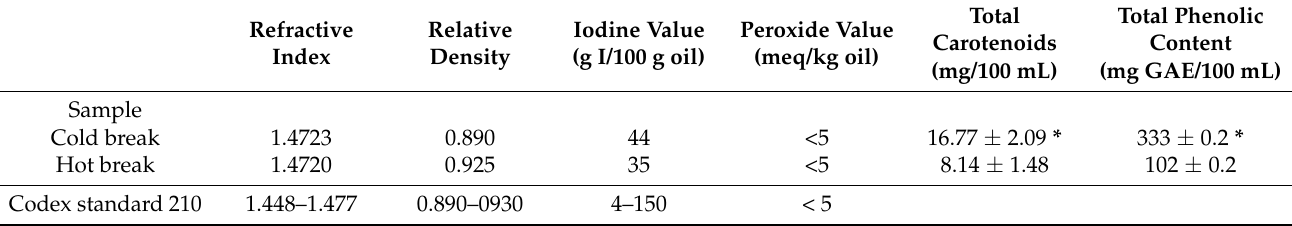
Table 2. Physical-chemical properties of tomato seed oils derived from cold break and hot break production lines; analytical measurements were conducted with three replicates ( n =